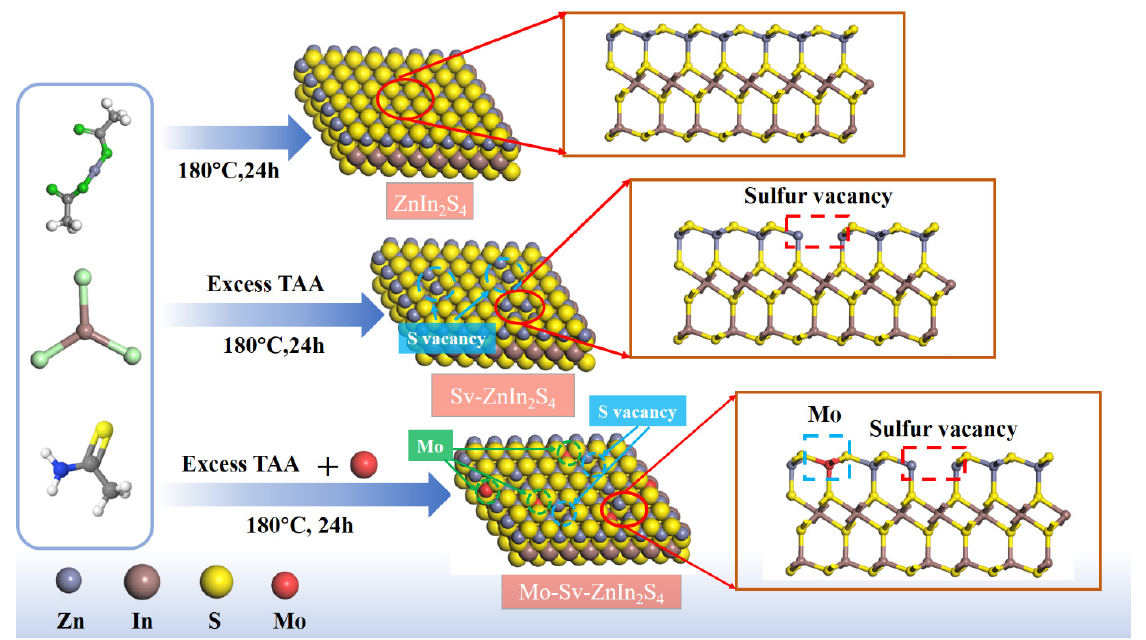
Figure 1. Schematic diagram of the synthetic routes for ZIS, Sv-ZIS and Mo-Sv-ZIS. The dotted red squares highlight the Sv. (The squares show the differences between the crystals).